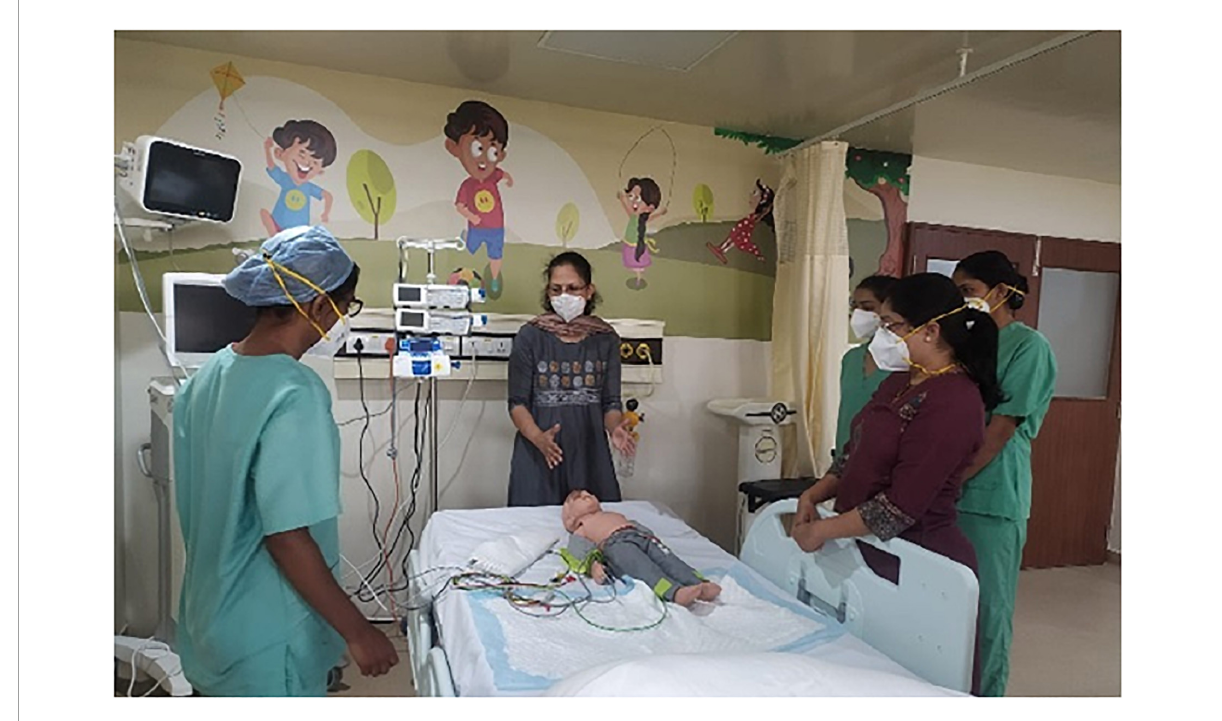
FIGURE2 Phase 4 Simulation in-situ team training in the